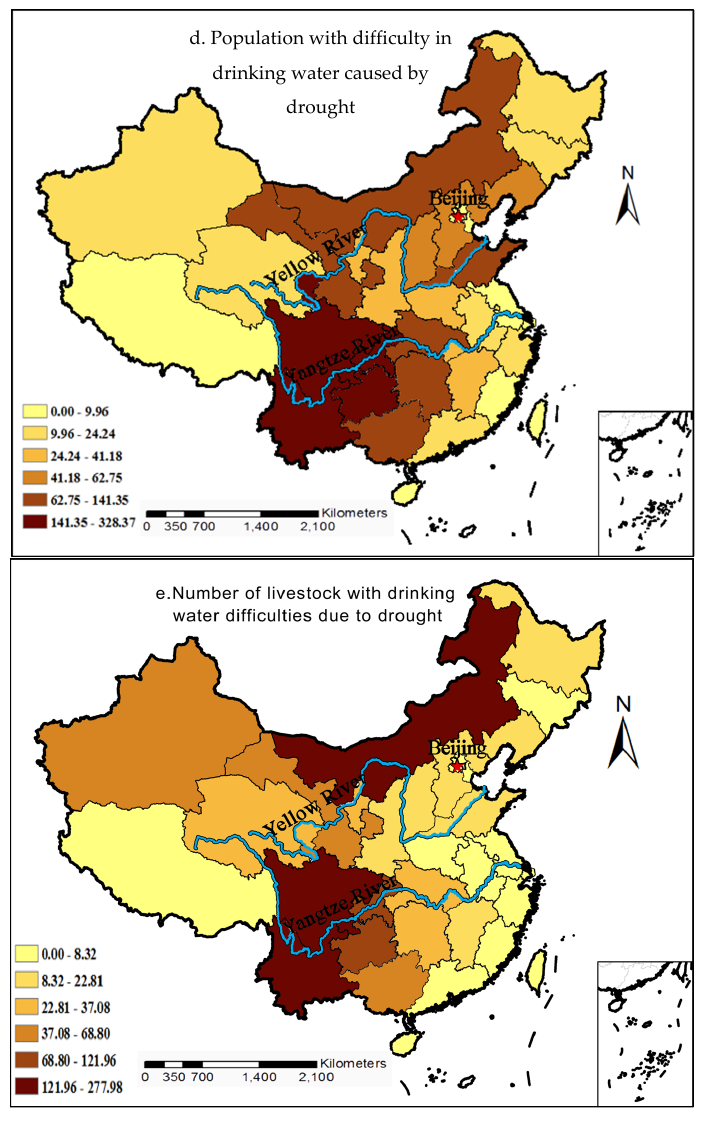
Figure 4. National average provincial drought disaster conditions.